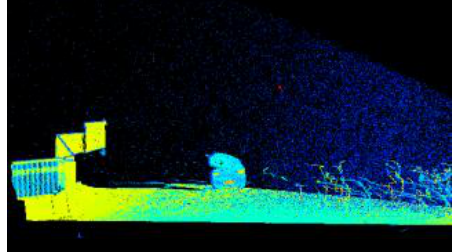
Fig. 3 Noisy data under fog haze weather condition